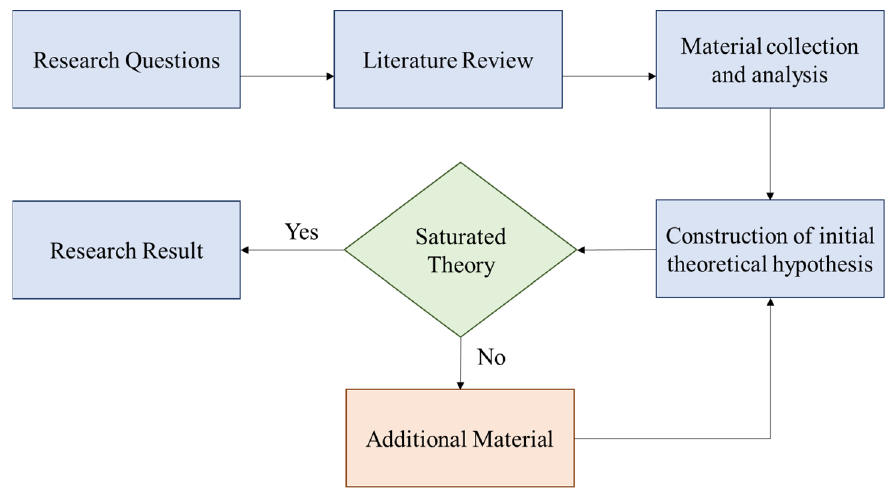
Figure 2. Research Procedure. Table 2. The process of conceptualization and categorization in the open